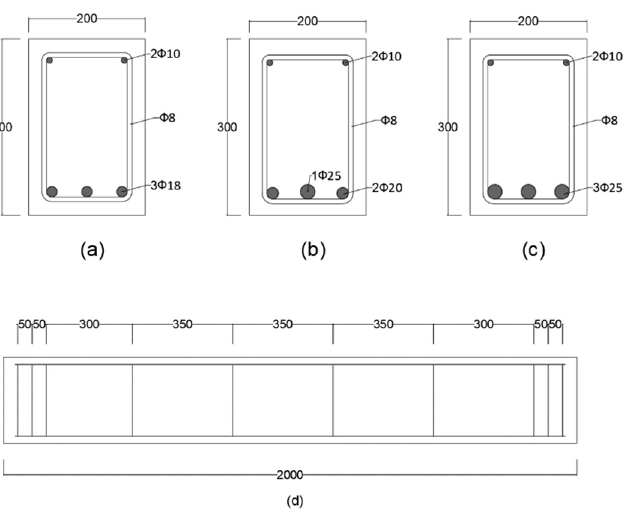
Figure 2. Beams’ geometry: ( a ) cross ‐ section of beams with 17 MPa, ( b ) cross ‐ section of beams with 32 MPa, ( c ) cross ‐ section of beams with 47 MPa, and ( d ) longitudinal section showing locations of internal stirrups (units: mm).